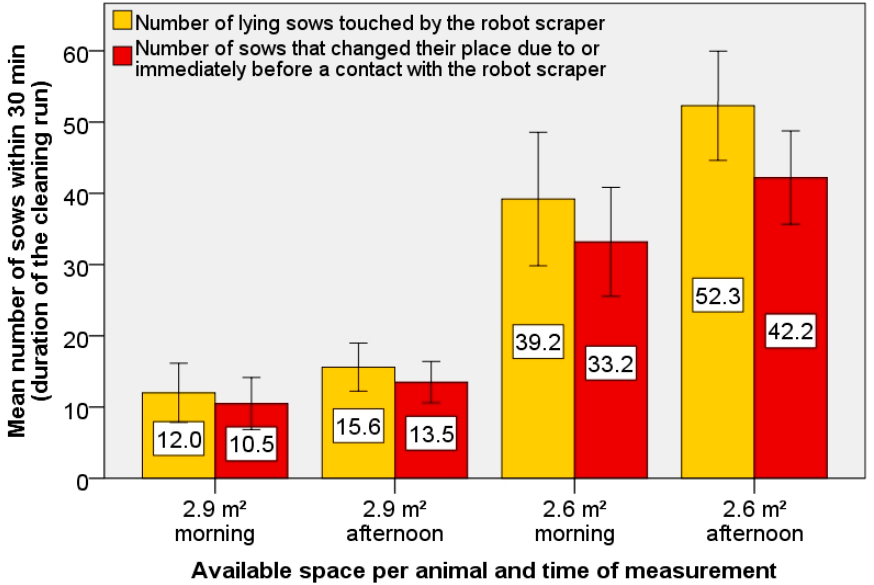
Figure 8. Representation of the average number of sows affected by the robot scraper during the cleaning process (yellow) and the average number of sows who changed their places as a direct result of the contact or immediately before the contact (red), separately shown for the observations in the morning (8:30 – 9:00 h) and afternoon (15:00 – 15:30 h) with different space of 2.9 square metres per sow (left) or 2.6 square metres per sow (right).